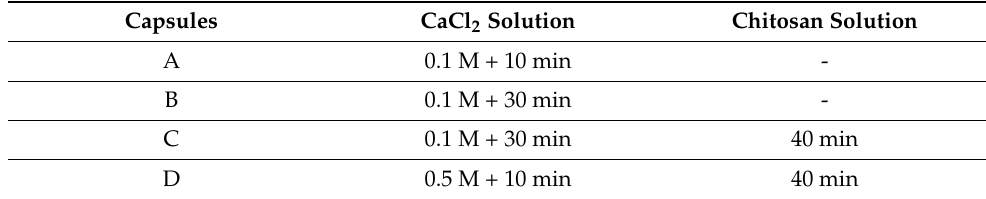
Table 1. Summary of the different capsules